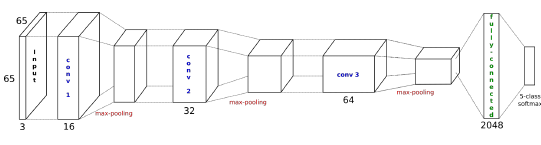
Figure 2. Proposed architectures: the 3-l CNN is represented, the 4-l has a similar scheme with a 4th convolutional and pooling